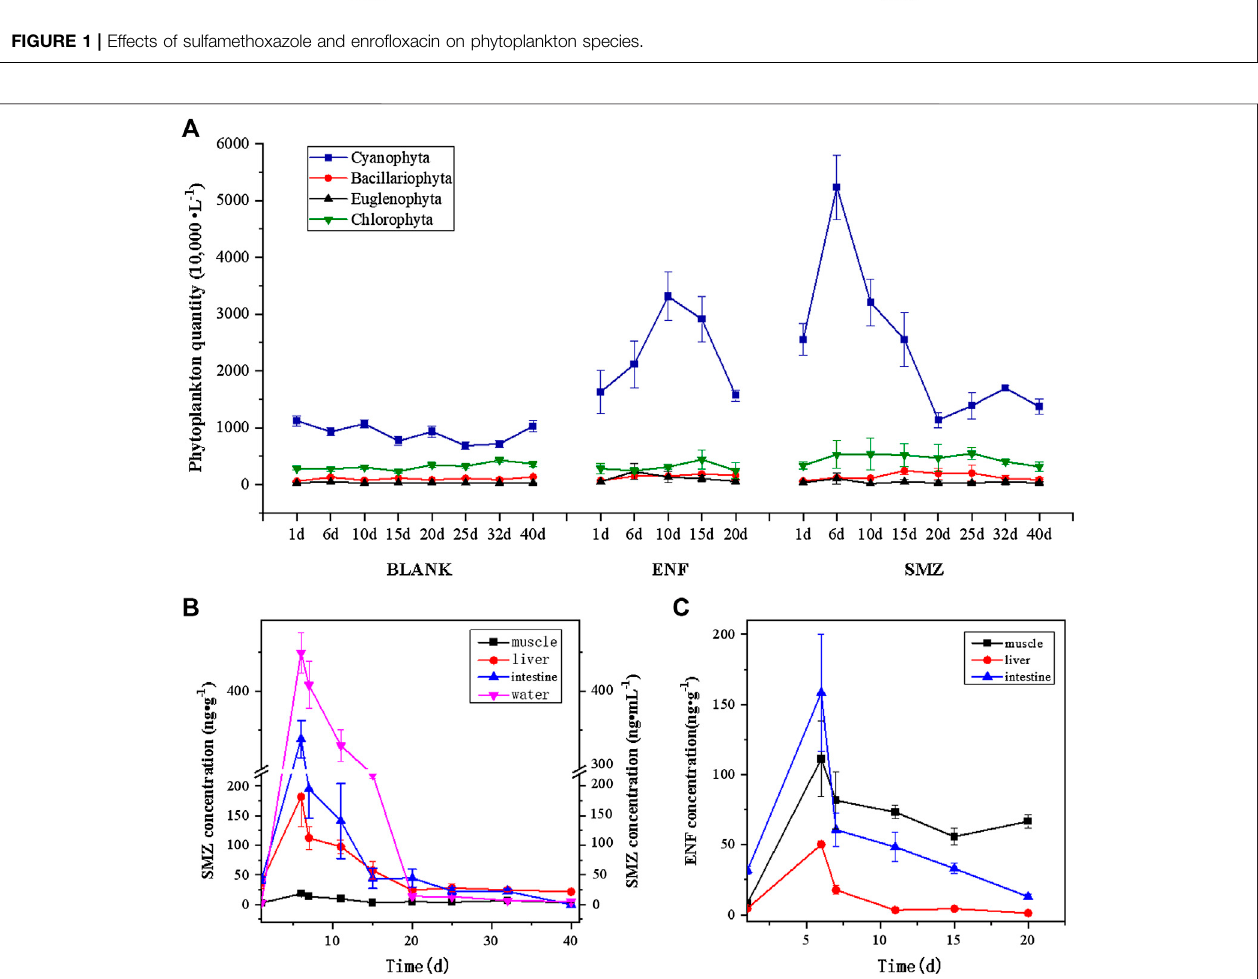
FIGURE 2 | Effects of sulfamethoxazole and enro fl oxacinon on phytoplankton population changes.